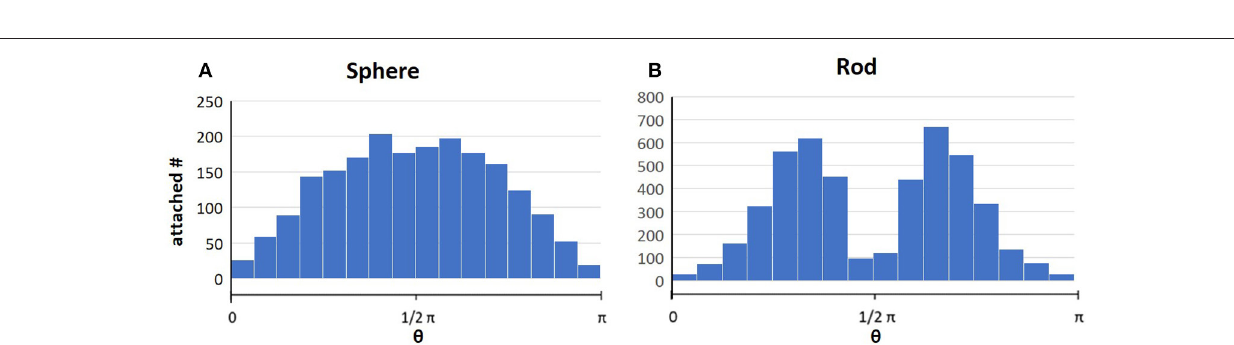
Frontiers in Water |